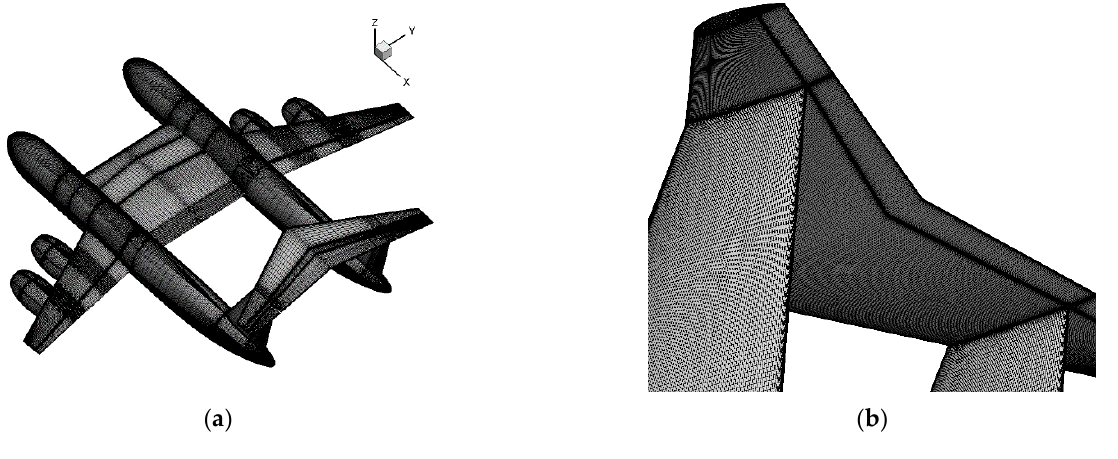
Figure 9. ( a ) Surface mesh of whole demonstration aircraft with a coarse gird. ( b ) Surface mesh of the T-tail with a fine grid.